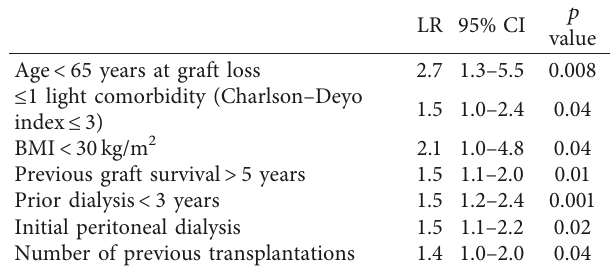
Table 3: Risk factors for graft loss in first and second transplantation.